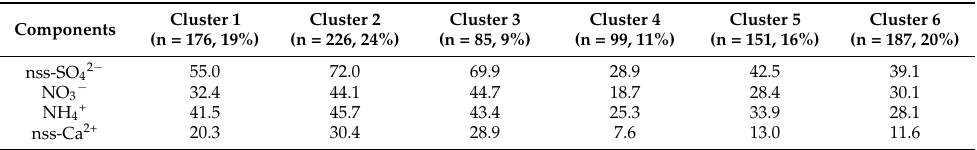
Table 7. Ionic concentration ( µ eq/L) of precipitation in accordance with airflow transport pathways determined via cluster back